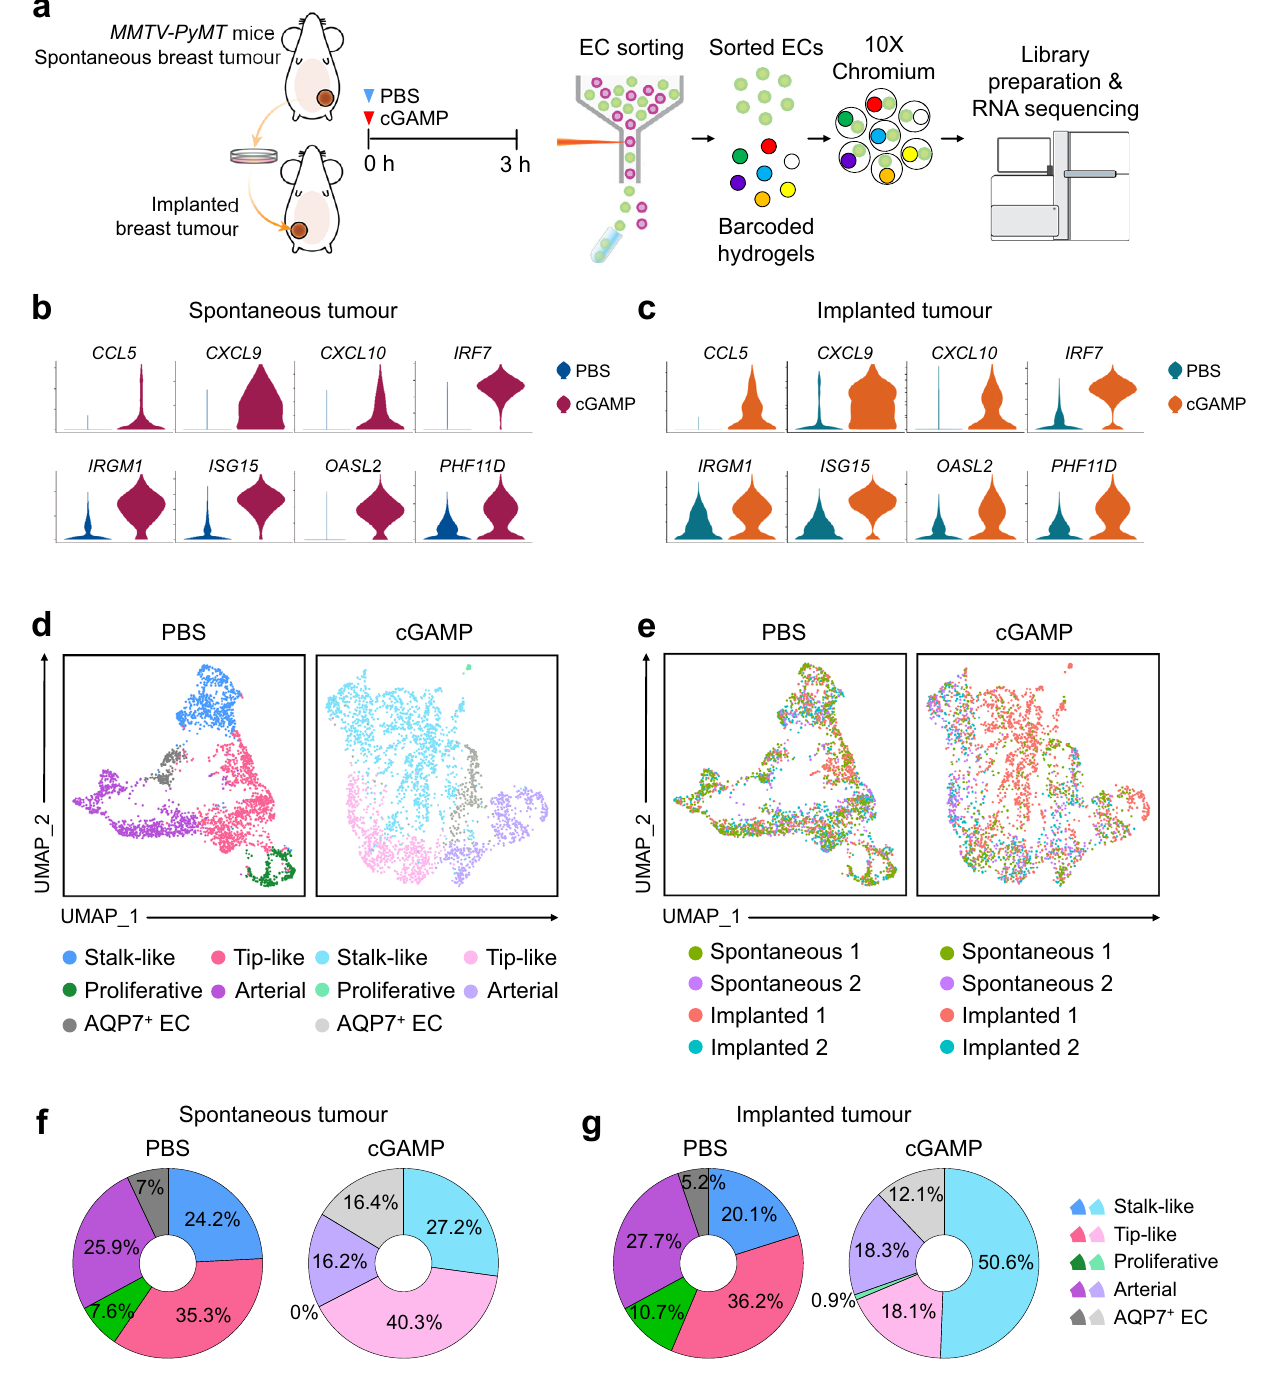
Fig. 8 Implanted, but not spontaneous, breast tumour ECs are vulnerable to STING activation-induced apoptosis. a Schematic diagram for depicting treatment, sampling, and scRNA-seq of tumour ECs in MMTV-PyMT spontaneous and their implanted breast tumours treated with i.t. PBS or cGAMP. n = 2 mice/each group. b , c Violin plots depicting the normalized expression levels of top-ranked differentially expressed genes in spontaneous and implanted tumour ECs. d UMAP plots comparing fi ve clusters of tumour ECs by unsupervised clustering, integrating datasets in spontaneous and implanted tumour ECs between PBS and cGAMP treatment. e The origin of datasets in each cluster. Each dot represents single cell. f , g Compositional differences of tumour EC subpopulations by treatments in spontaneous and implanted tumour